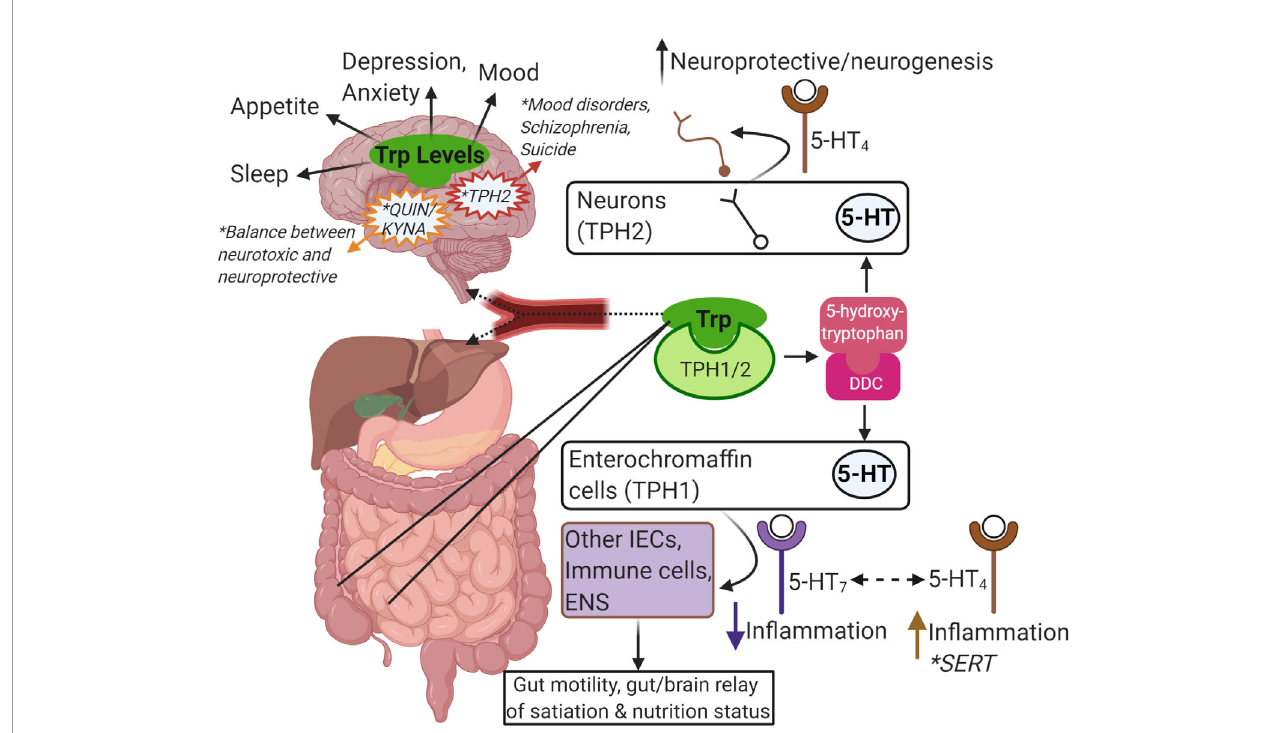
FIGURE 2 | Summary of Trp-centric gut-brain axis. Trp from food or microbes is absorbed in the intestine. From there, it can be metabolized by IECs or immune cells in the intestinal mucosa, or it can enter the blood stream (as free Trp or bound to albumin). Once in the blood stream it is absorbed by other tissues in the periphery like the liver or continues to the brain through the blood-brain-barrier to get metabolized by neurons, astrocytes and glial cells. Trp is metabolized by TPH1/ 2 and further metabolized by DDC to serotonin (5-HT). Intestinal epithelial enterochromaf fi n cells are the major source of 5-HT in the gut and is important in gut motility and in communicating nutritional status to the brain via the ENS. Depending on the receptor, 5-HT can also impact in fl ammatory responses in other IECs or local immune cells. SERT is responsible for breaking down 5-HT, and reduced SERT levels has been linked to IBD and IBS. In the brain, 5-HT is important in neuroprotection and neurogenesis. In general, the levels of Trp and its metabolites are linked to many brain functions, mood, and mental health disorders (e.g. mutations in TPH2, the balance of Kyn metabolism into QUIN and KYNA). This image was created in BioRender.com. Trp, tryptophan; IEC, intestinalepithelial cells; TPH, tryptophan hydroxylase; DDC, dopa decarboxylase; 5-HT, serotonin; ENS, enteric nervous system; SERT, SLC6A4, 5-HT transporter; IBD,in fl ammatory bowel disease; IBS, irritable bowel syndrome; Kyn, kynurenine; QUIN, quinolinic acid; KYNA, kynurenic